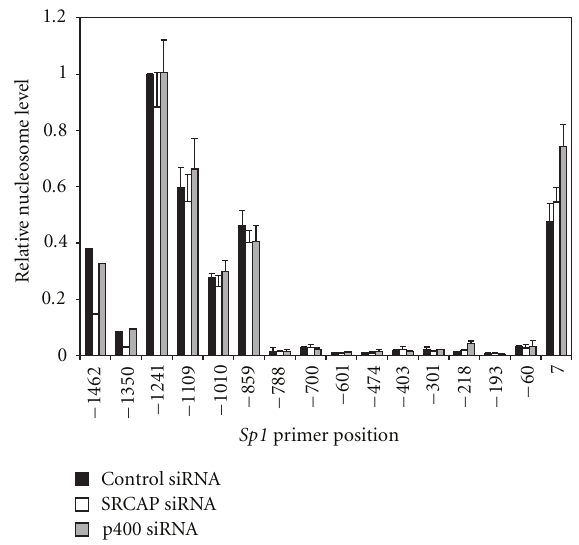
Figure 4: The density of nucleosomes at the Sp1 promoter is not altered in the absence of SRCAP or p400. A549 cells were transfected with control, SRCAP or p400 siRNA and harvested 72 hours later. DNA was isolated from mononucleosomes and amplified by qPCR using overlapping primer sets tiling the Sp1 promoter (see Table S2) and presented relative to the amount of DNA amplified at position − 1241. The graph represents the mean result and standard error of three or more independent ChIP